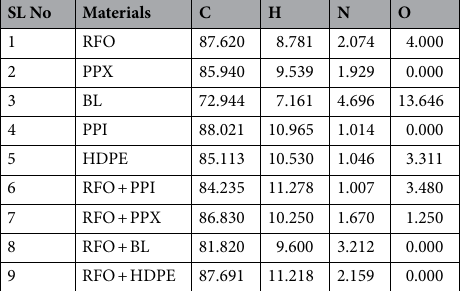
Table 5. Ultimate analysis of liquid product obtained from co-cracking of RFO with various plastics waste in the presence of ZSM-5